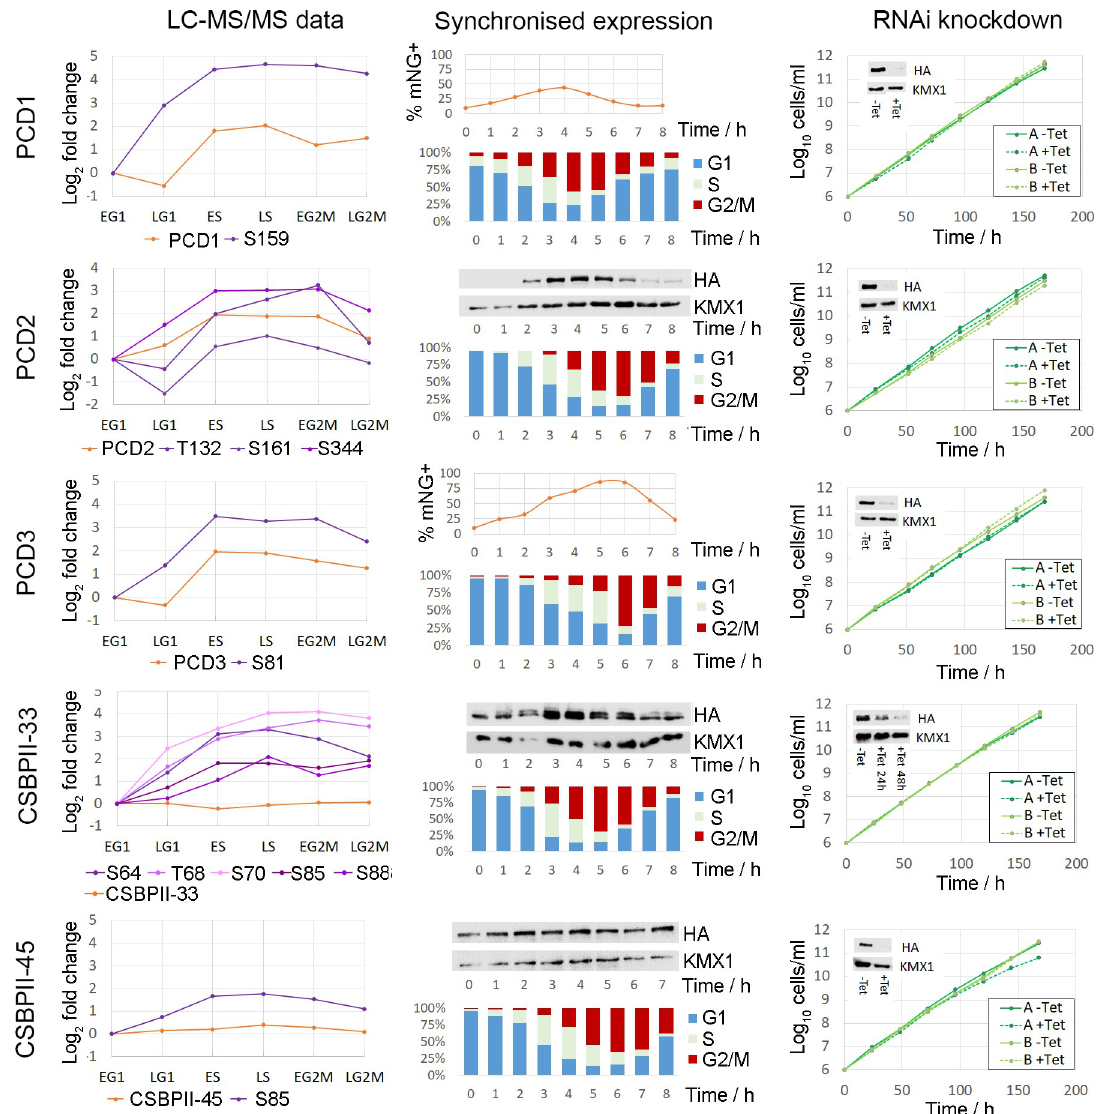
Fig 9. PSP1-C domain containing proteins are CCR but not essential. Left panel–CCR changes in phosphorylation site and protein abundance relative to early G1 (EG1). Centre panel–Expression profile of tagged proteins in cells synchronised in early G1 by centrifugal elutriation; flow cytometry of PI stained cells for cell cycle position, and corresponding analysis of protein expression by flow cytometry (mNeonGreen) or western blot (HA). Right panel–cumulative cell growth with and without induction of RNAi by addition of tetracycline for two independent cell lines; insets show western blot of HA-tagged proteins and KMX1 tubulin loading control.